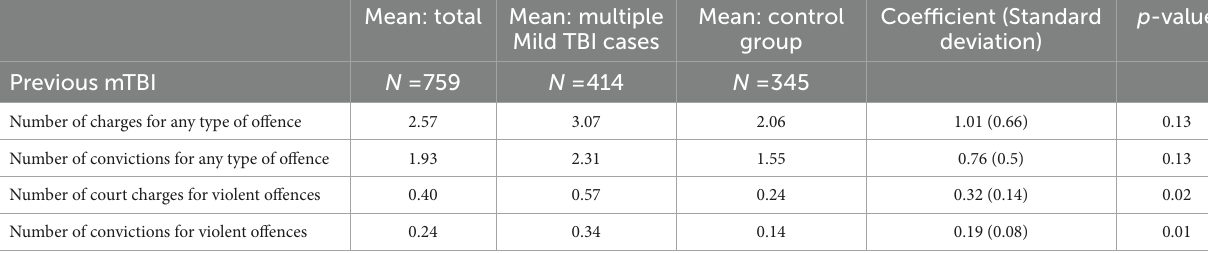
TABLE 2 Criminal behaviour outcomes between multiple mTBI cases and the orthopedic control group with a TBI history.